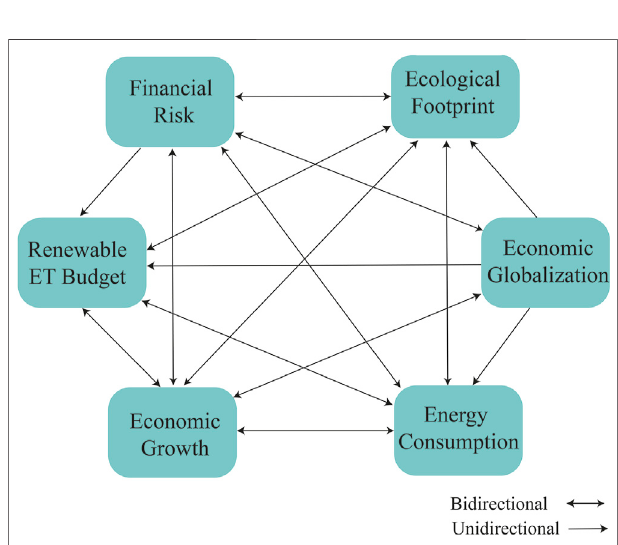
FIGURE 6 | Visual representation of panel granger causality test results.